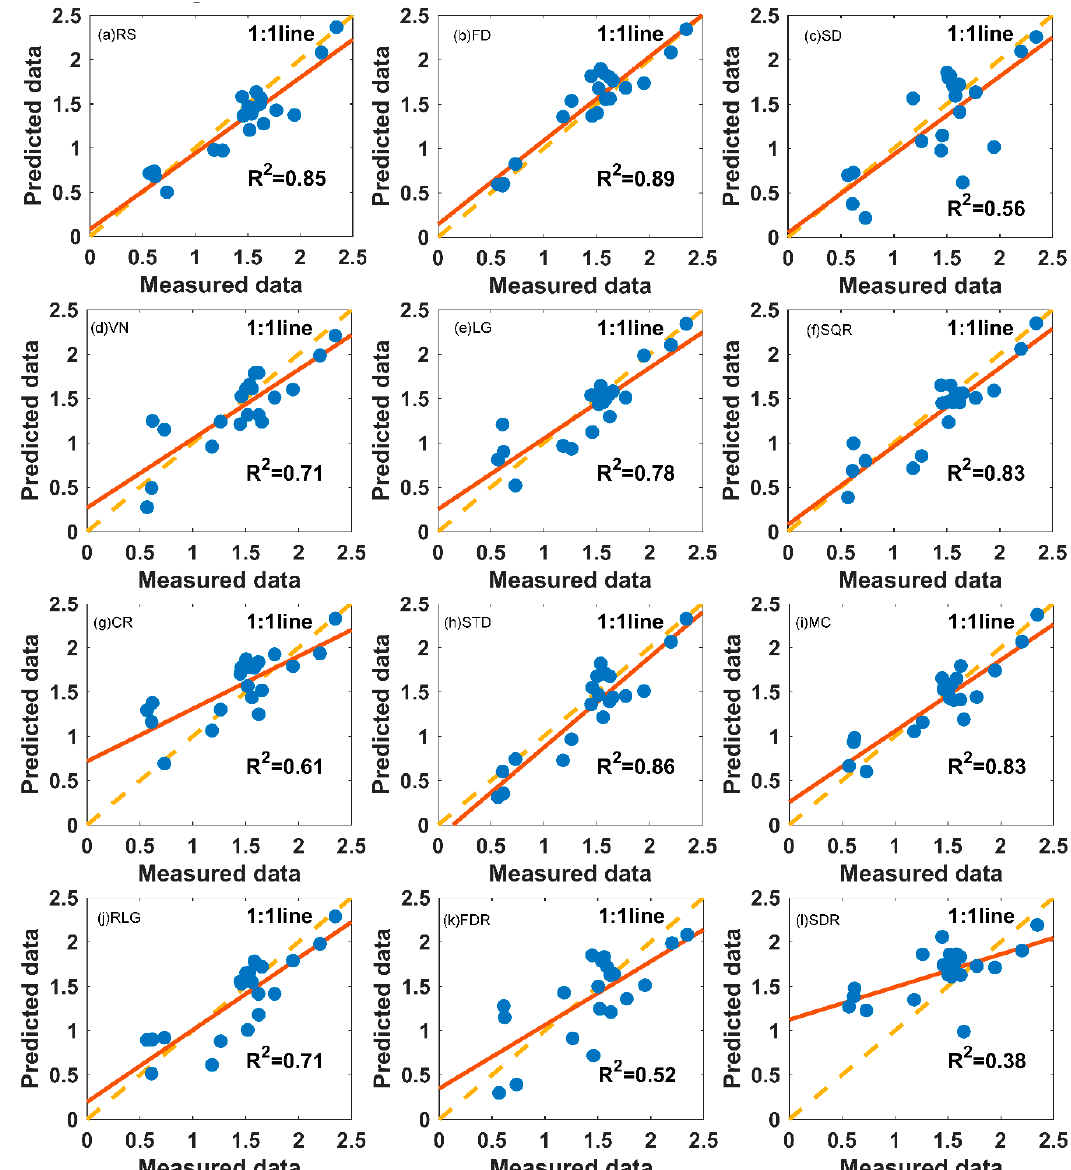
Figure 9. SPA–PLSR estimate results. ( a ) RS–SPA–PLSR estimate results, ( b ) FD–SPA–PLSR estimate